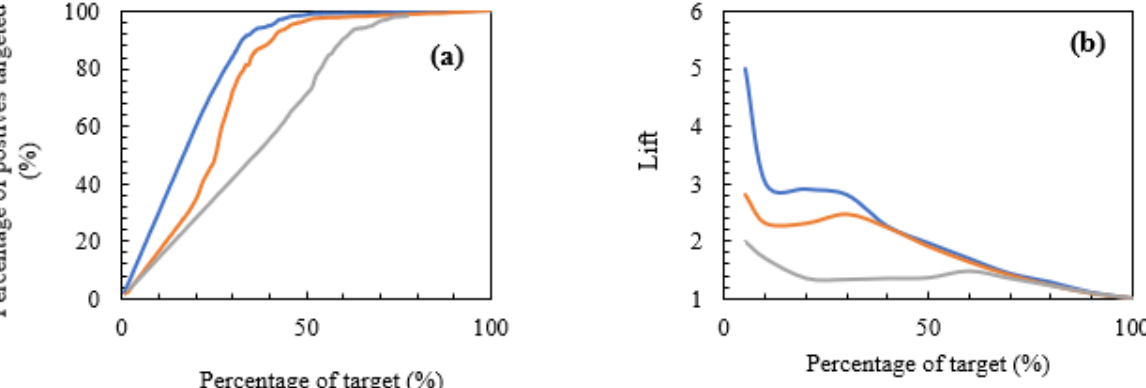
Figure 6. Multinomial classification graphs. ( a ) Cumulative gains curve, ( b ) lift curve.